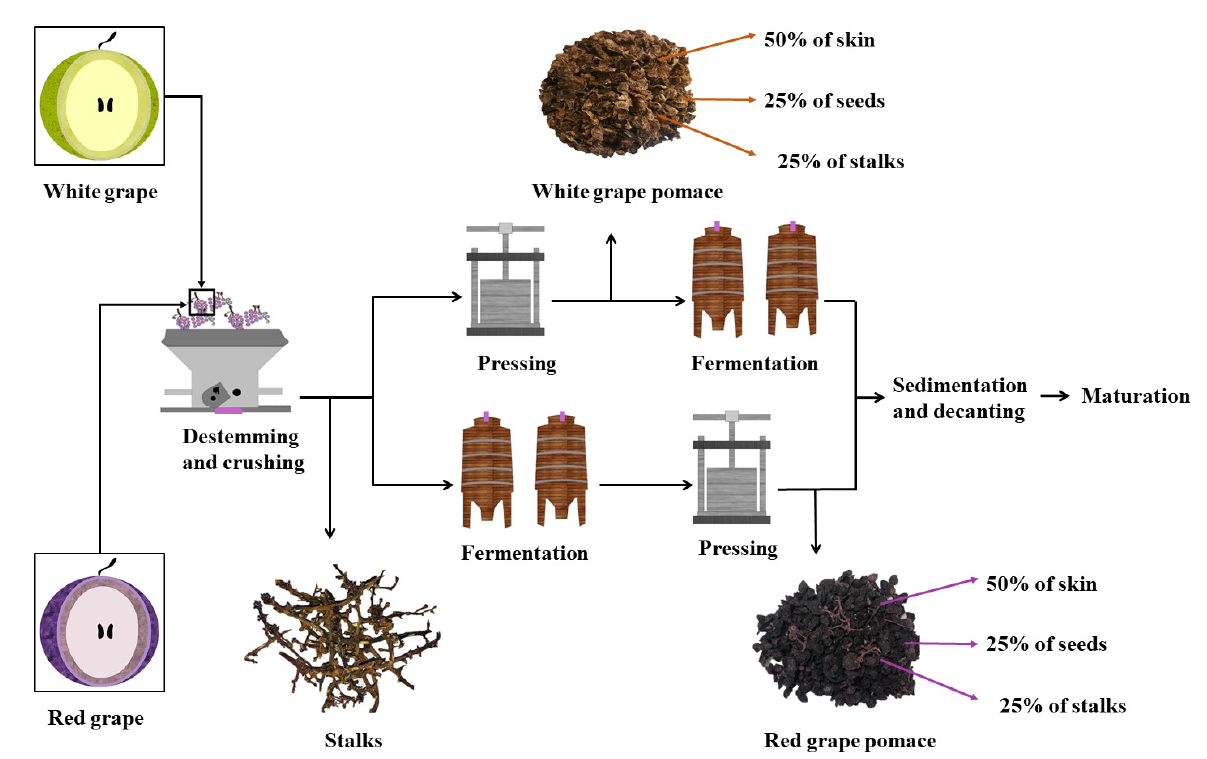
Figure 1. Grape pomace derived from the wine making process.